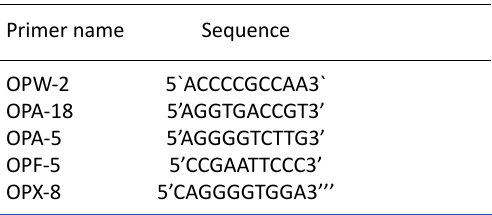
Table 1. Primer sequences used in